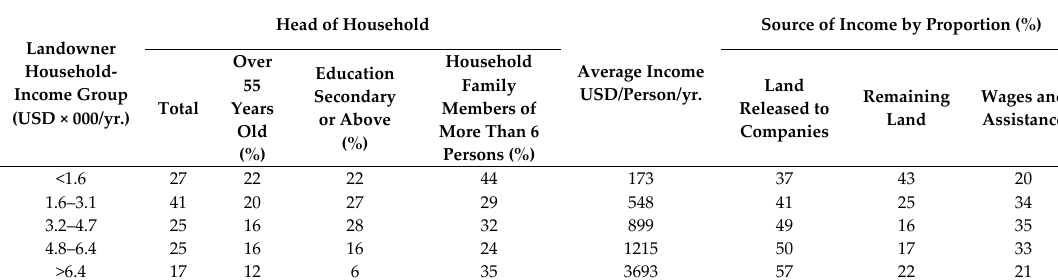
Table 3. Socio-demographics and livelihoods of landowners of various income levels.